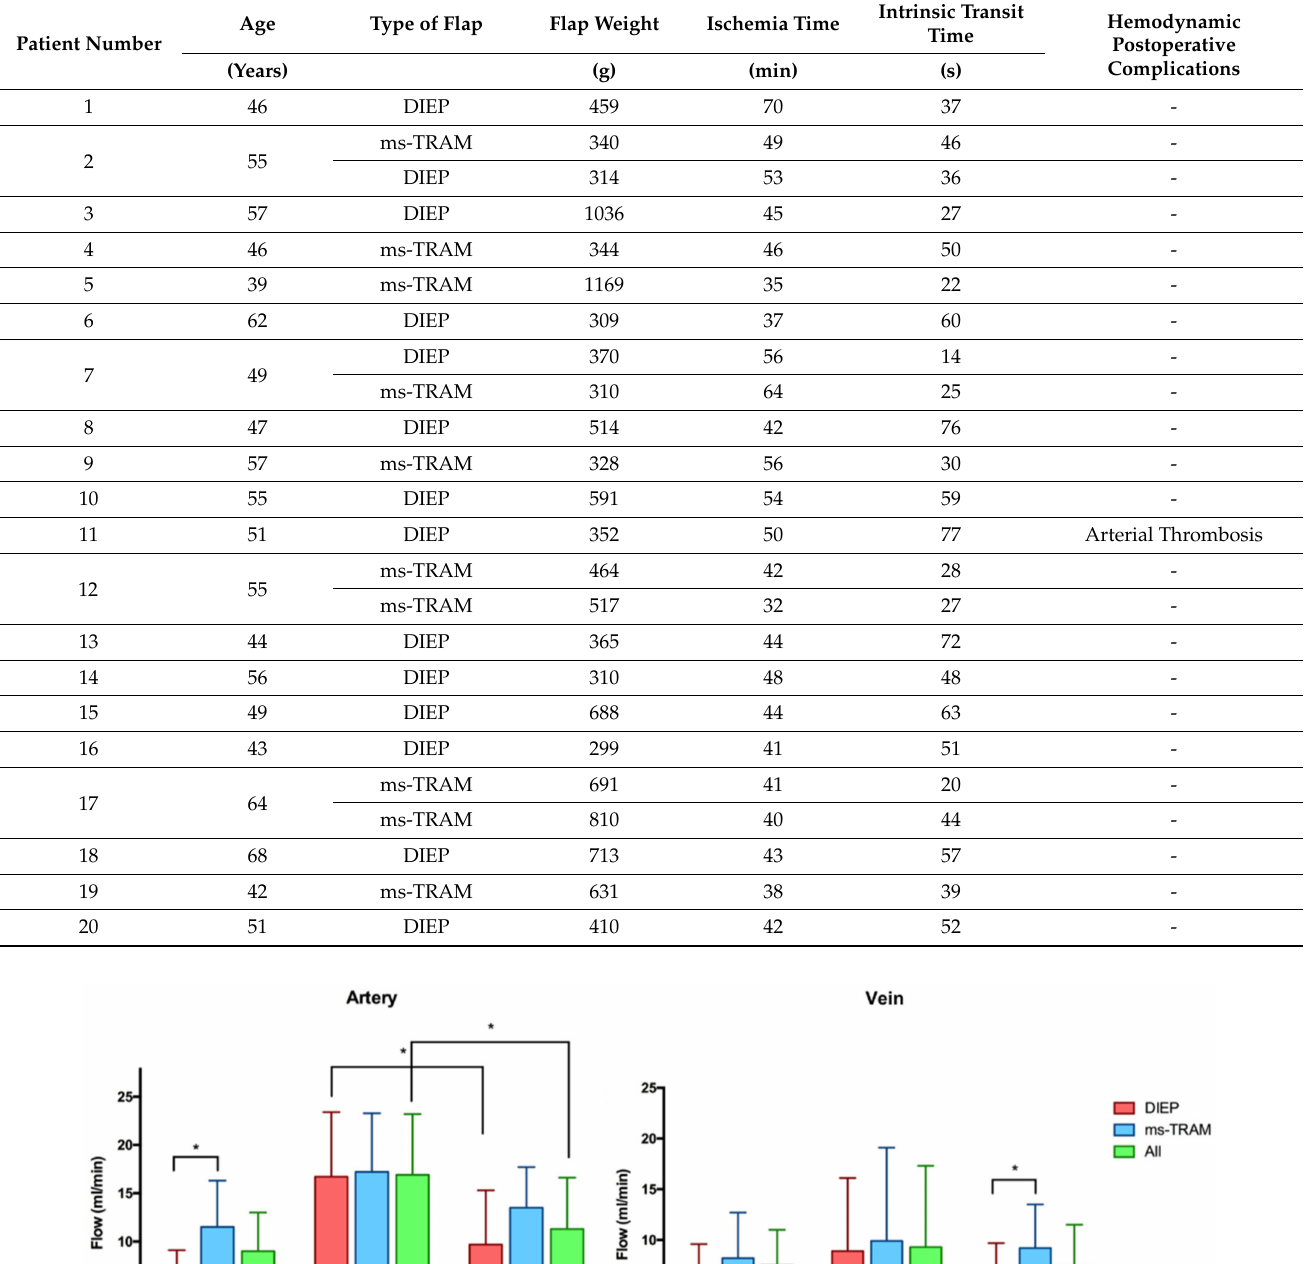
Table 1. Characteristics of the included patients. Abbreviations: DIEP: deep inferior epigastric